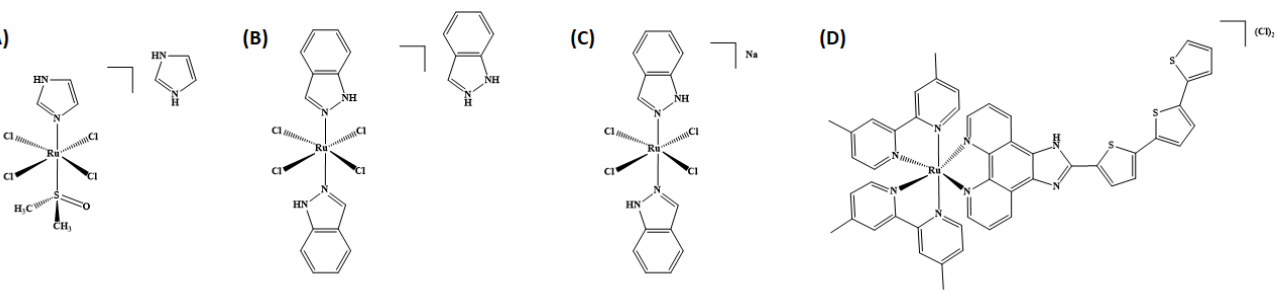
Figure 1. Structure of ruthenium(III) and ruthenium(II) complexes that have achieved clinical trials: ( A ) NAMI-A, ( B ) KP1019, ( C ) NKP-1339, and ( D ) TLD1433.